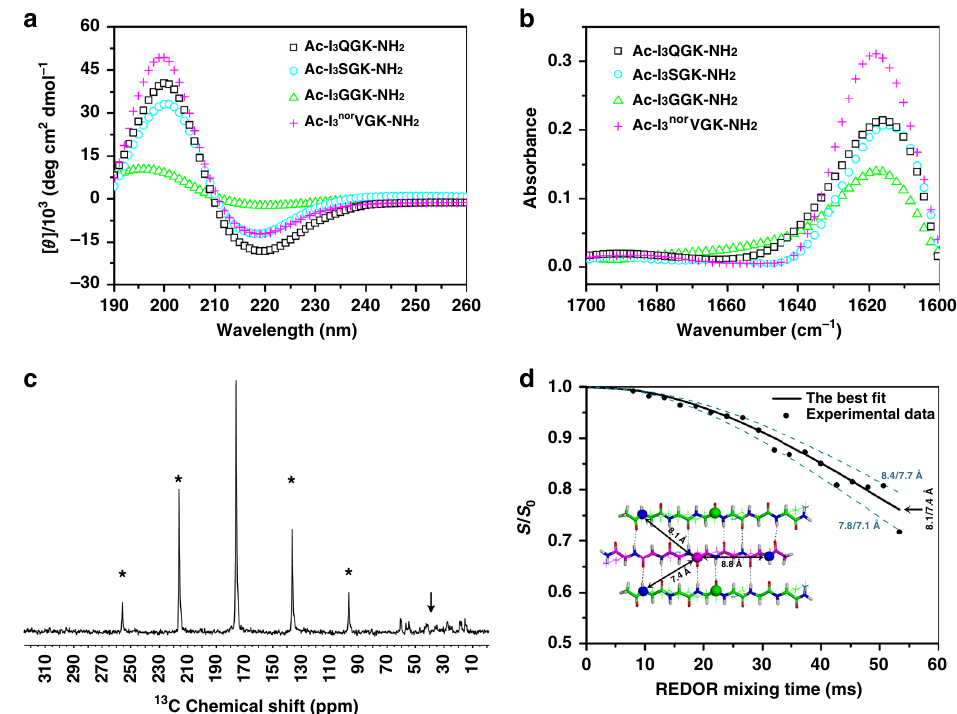
Fig. 6 Secondary structures and molecular packing modes. a , b CD and FTIR spectra of the designed peptides at 8 mM except for Ac-I 3 GGK-NH 2 at 16mM. For clarity, the CD spectra of Ac-I 3 NGK-NH 2 and Ac-I 3 LGK-NH 2 are given in Supplementary Figures 3b and 6b, respectively, but also indicating the formation of β -sheet conformations. c 1 H- 13 C CP spectrum of [ 15 N]Ile1[1- 13 C]Ile3-Ac-I 3 QGK-NH 2 nanoribbons. Rotational sidebands are denoted by asterisks and the down arrow denotes natural abundance 13 C signals. d Experimental 13 C{ 15 N} REDOR data (black dots) of [ 15 N]Ile1[1- 13 C]Ile3-Ac-I 3 QGK-NH 2 nanoribbons. The REDOR curve (black solid line) was fi tted by SIMPSON using one intra-strand and two inter-strand 13 C- 15 N spin pairs with corresponding 13 C- 15 N distances of 8.8, 7.4, and 8.1Å, respectively, which were extracted from the one-residue shift packing mode (inset). The anti-parallel trimer with one-residue shift shown in the inset ( 13 C: pink or green sphere and 15 N: blue sphere) was the central core of an Ac-I 3 QGK-NH 2 oligomer of 6 strands × 4 sheets during MD simulations. To demonstrate fi tting uncertainty, the dashed lines were calculated using the indicated inter-strand 13 C- 15 N